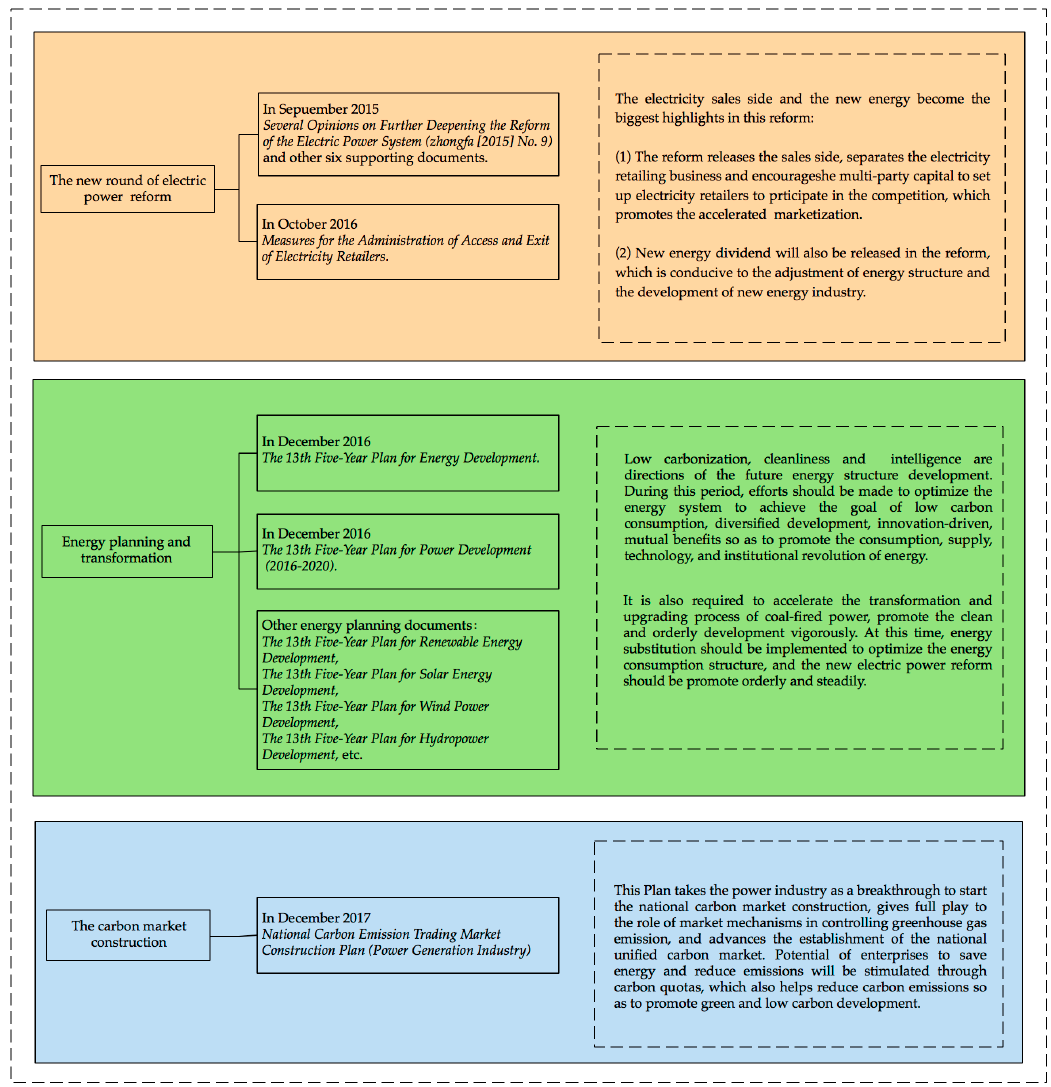
Figure 1. Policy documents on the implementation of energy saving and emission reduction actions for electric power industry in China.